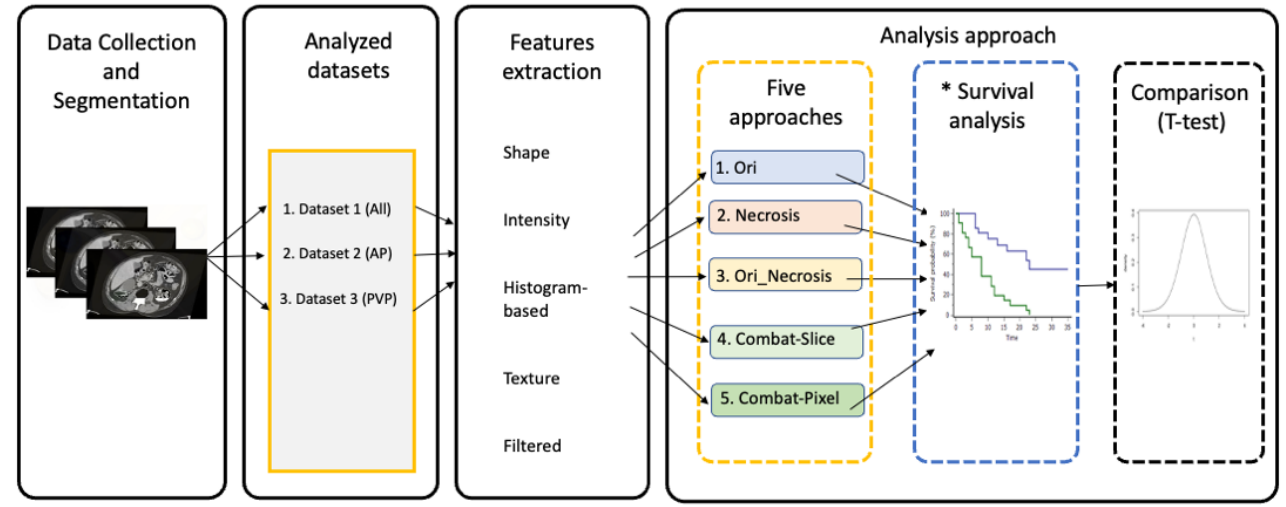
Figure 1. Study workflow. * The survival analysis is performed 1000 analyses per approach.